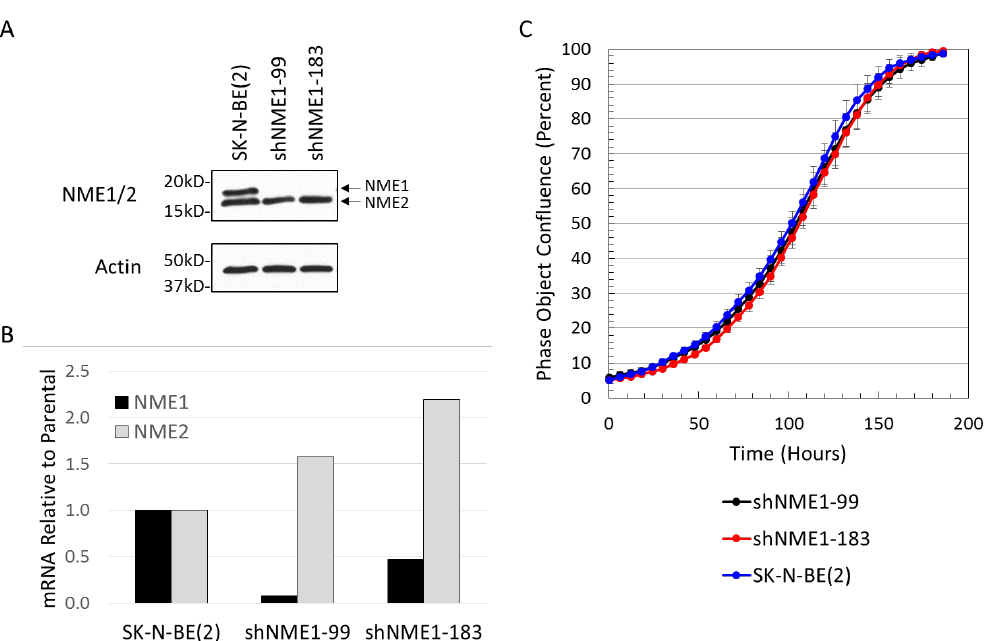
Figure 4. NME1 depletion in neuroblastoma cells. ( A ) SK-N-BE(2) neuroblastoma cells were transfected with shRNA’s directed against NME1 (shNME1-99, shNME1-183) or with control shRNA (mock) and analyzed by Western blot ( A ) and Q-PCR ( B ) for NME1 and NME2 protein and gene expression, respectively. ( C ) Control SK-N-BE(2) neuroblastoma cells and cells with depleted NME1 (shNME1-99, shNME1-183) were plated and analyzed for cell confluence over time using continuous live cell imaging.